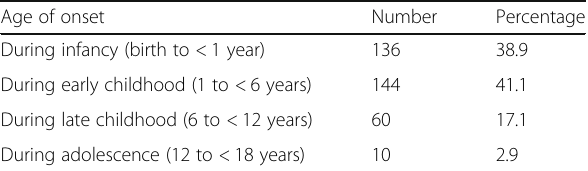
Table 3 Age of onset of epilepsy among the studied patients Age of onset Number